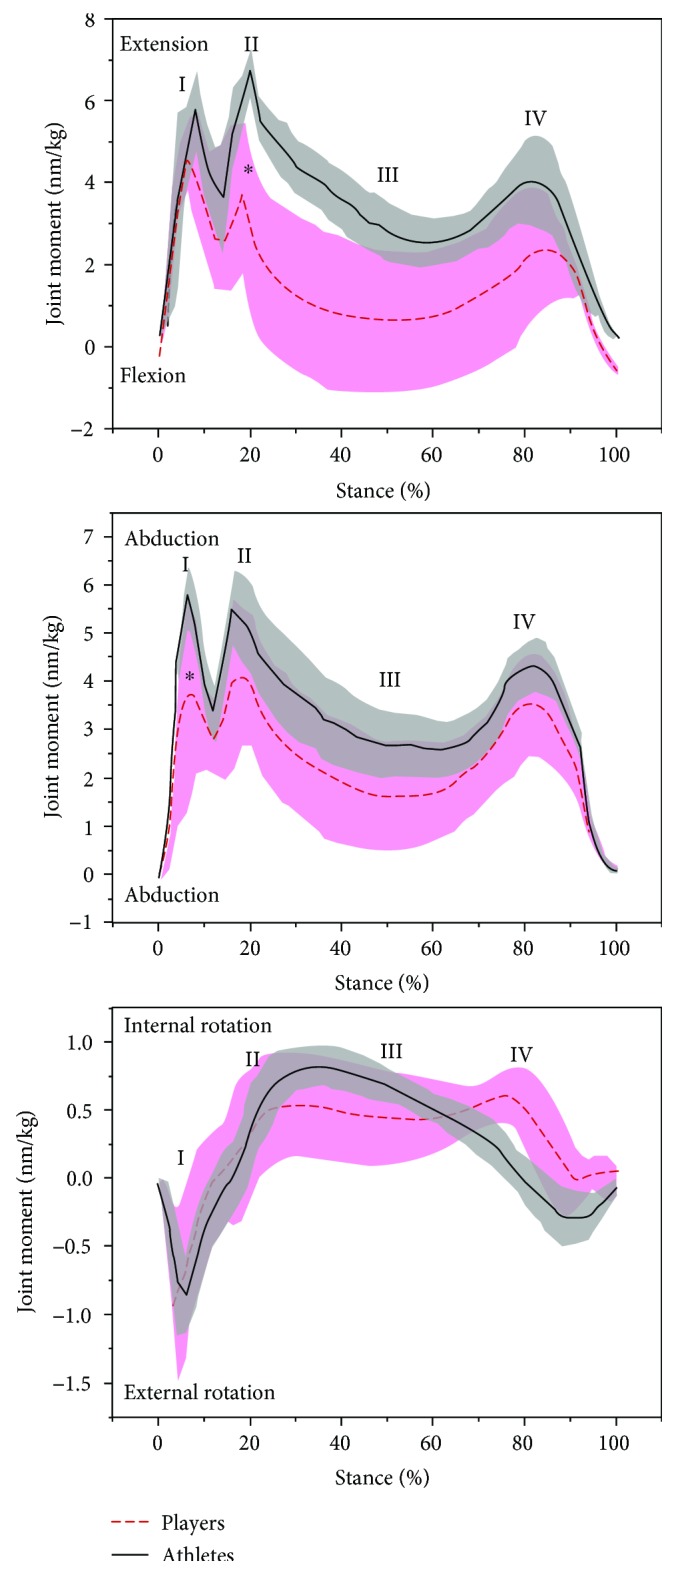
The mean (standard deviation—shadow with bars) value of knee joint moment in the sagittal (extension/flexion), frontal (abduction/adduction), and horizontal (internal rotation) planes between professional and amateur badminton players (∗ indicates significance level p < 0.05).